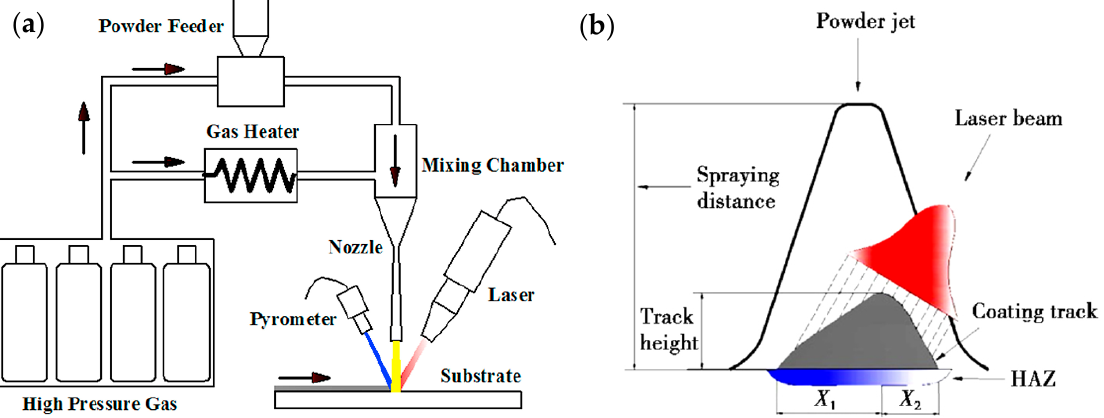
Figure 15. ( a ) Basic structure of supersonic laser deposition system [78] and, ( b ) distribution of laser energy and powder deposition state in deposition area [87].